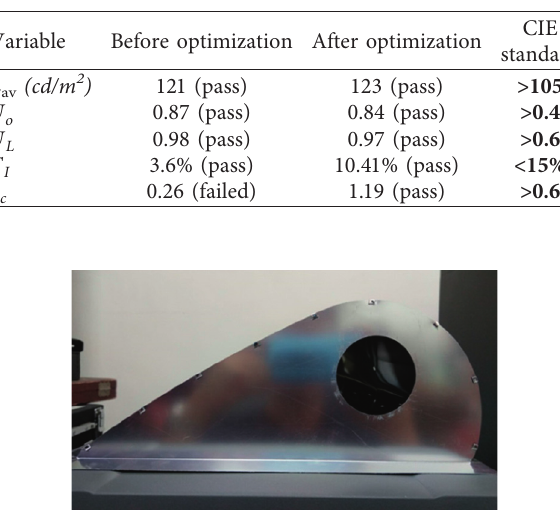
Figure 12: The prototype of the optimized CBL reflector.